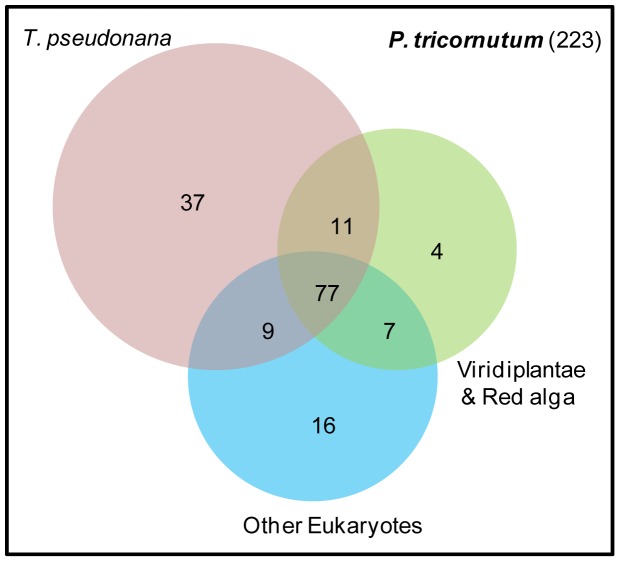
Venn diagram showing how many of the silicic acid regulated genes identified in P. tricornutum are also found in some other lineages.Representation of shared/unique Si-sensing genes in P. tricornutum, T. pseudonana, Viridiplantae (i.e., plants and green algae) & red algae, and other Eukaryotes (i.e., other Chromalveolates and Opisthokonta and Alveolates).